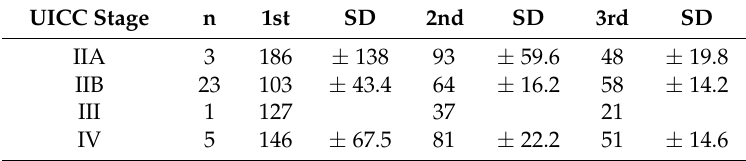
Table 1. Average days (mean) of in vivo tumor growth for xenograft expansion until tumor harvest. UICC Stage n